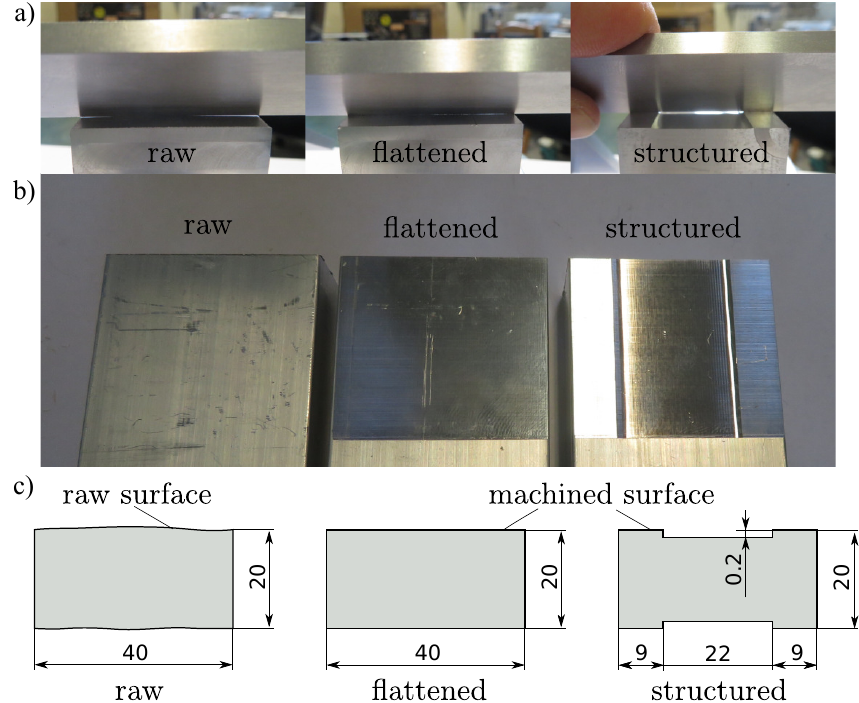
Figure 2. Different clamping surfaces of the turbine blade: the raw surface in the left, flattened in the middle and the structured surface in the right column. ( a ) The top row shows the picture of the surface contours created by a light test, ( b ) the middle row shows the picture of the clamped surface sections and ( c ) the bottom row shows the (non-scaled) schematic drawing of the